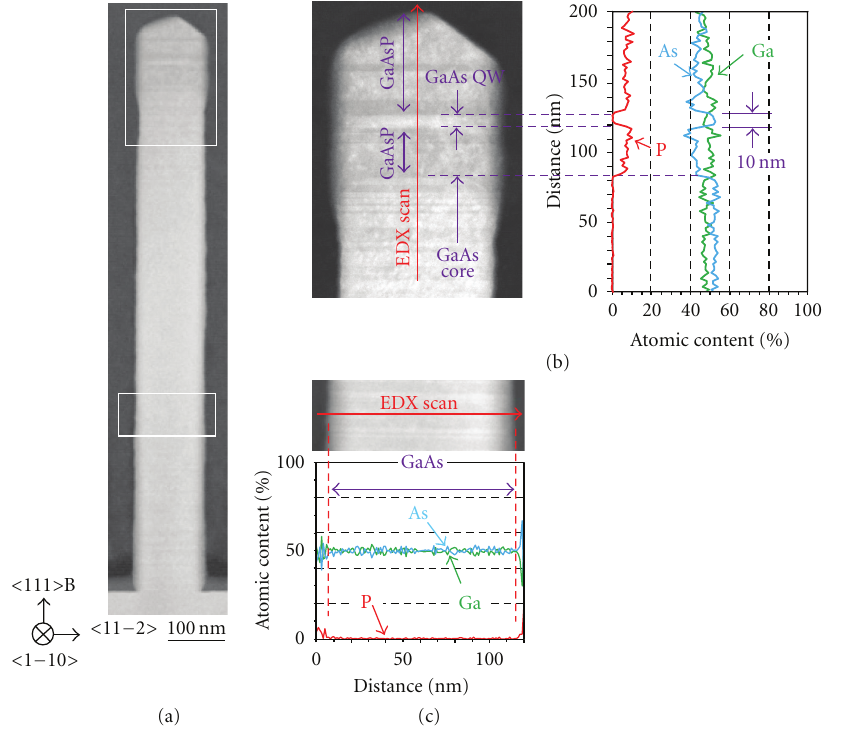
Figure 16: TEM/EDX analysis of heterostructure NW with GaAs QW. (a) Dark-field STEM (DF-STEM) image of NW. (b) DF-STEM image at top of NW of (a) and atomic content profiles for Ga, As, and P measured by EDX. (c) DF-STEM image at center-bottom part of NW and atomic content profiles obtained by